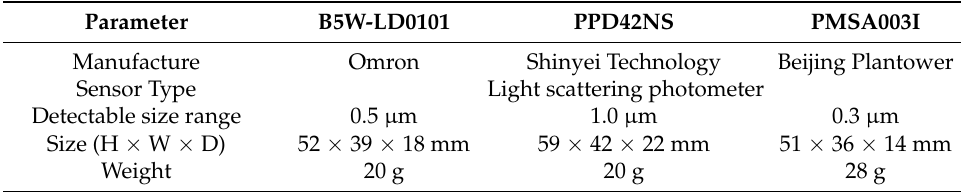
Table 2. Major specifications of three PM